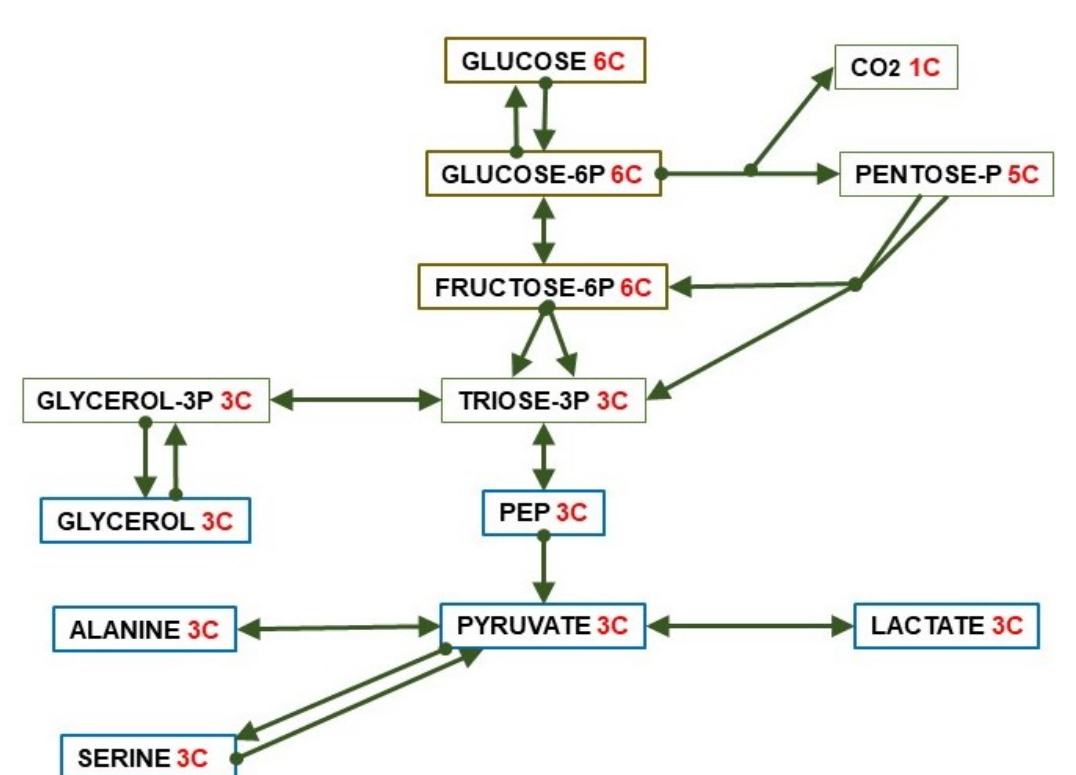
Figure 2. Paths of conversion of glucose (6C) to 3C fragments.